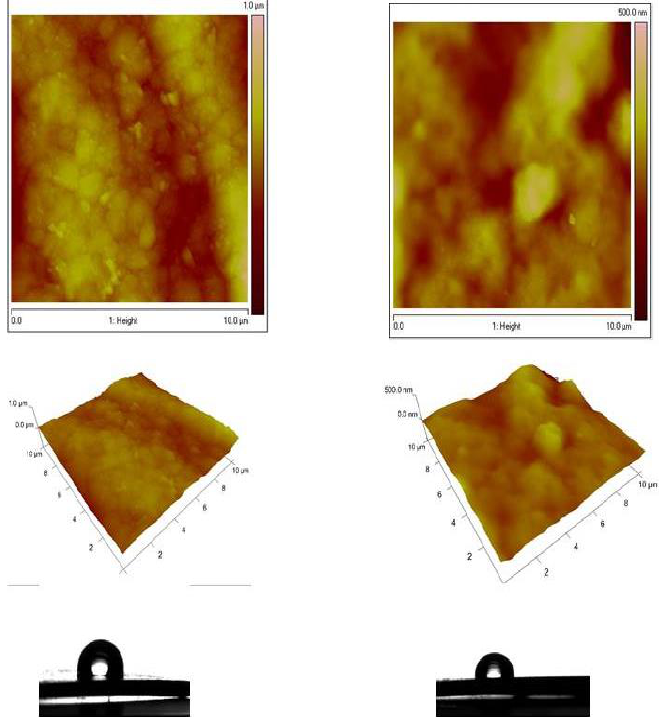
Figure 8. AFM topography of Zn-Co alloy and Zn-Co/TiO 2 (System B) samples: 2D images, 3D im- ages and water contact angle.